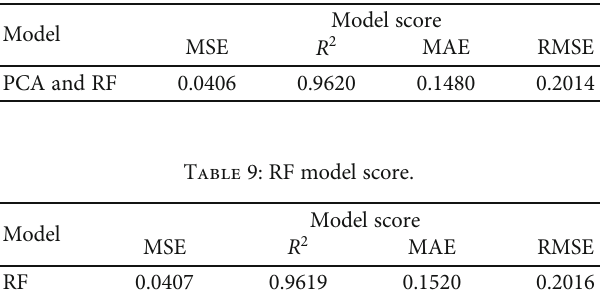
Table 8: PCA+RF model score.